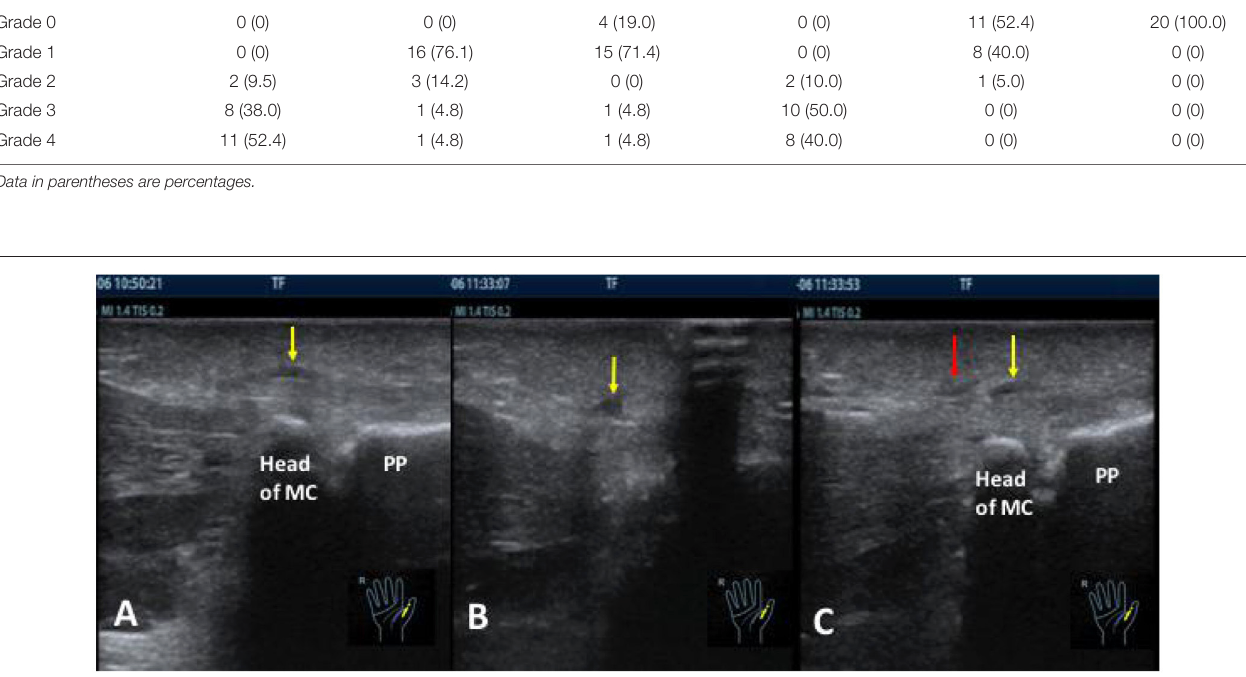
significant improvement in clinical grade after release ( p <